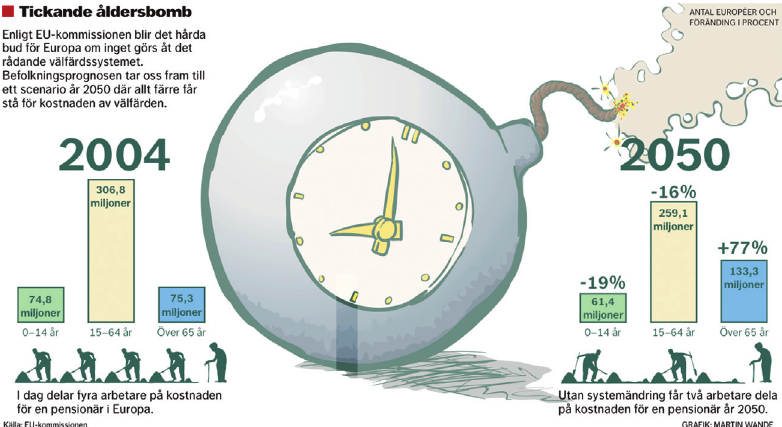
Figure 1. Population ageing as a ticking time bomb (from DN, No v ember 24,